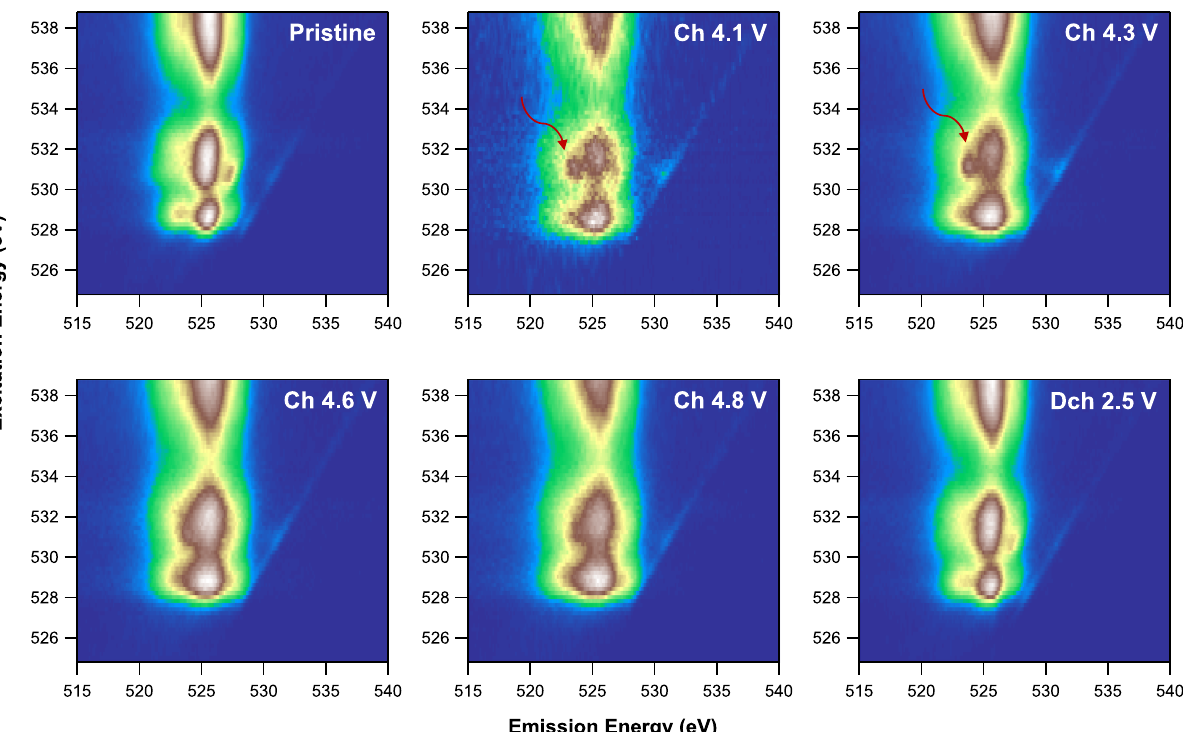
Fig. 5 Anionic redox mechanism of Li 1.2 Ni 0.4 Ru 0.4 O 2 . O K -edge mRIXS results at different electrochemical states. Red arrows indicate the fi ngerprinting feature of oxidized oxygen at the excitation and emission energy of 531 and 523.7 eV, respectively. The feature emerges at 4.1 V during charge and disappears in the following discharge, clearly revealing a reversible lattice oxygen-redox